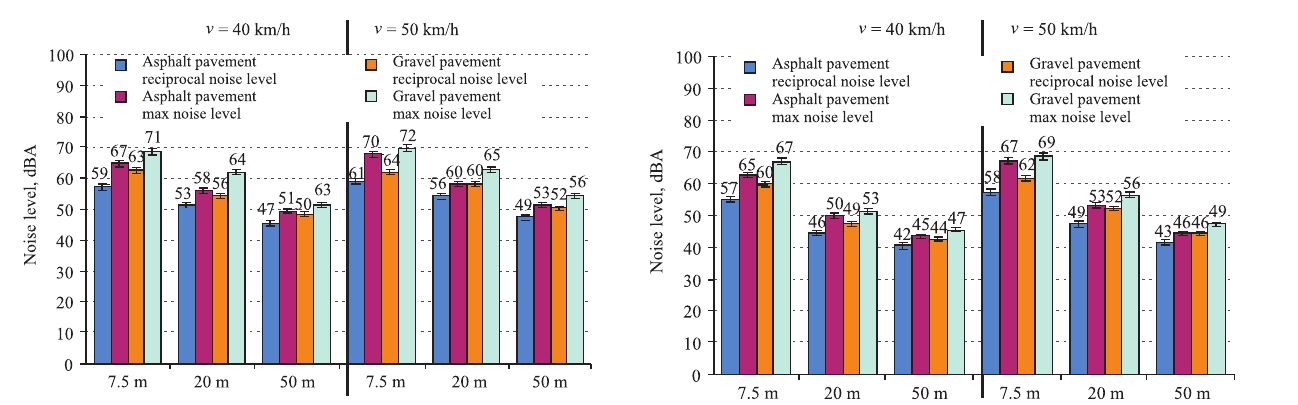
Fig. 7. Dependence of reciprocal and max noise levels on car speed when driving on road with gravel pavement and AP in wintertime